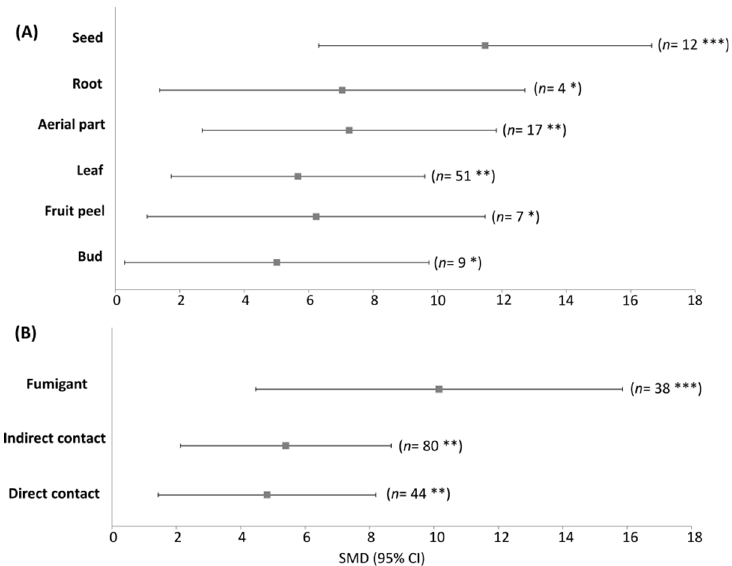
Figure 4. Meta-analysis of the insecticidal effect of EOs against mealybugs of the Pseudococcidae family using plant parts ( A ) and application method ( B ) as moderating variables. The EOs from plant parts and application method with significant effects are shown in bold. *** p <0.001, ** p < 0.01, and * p < 0.05.